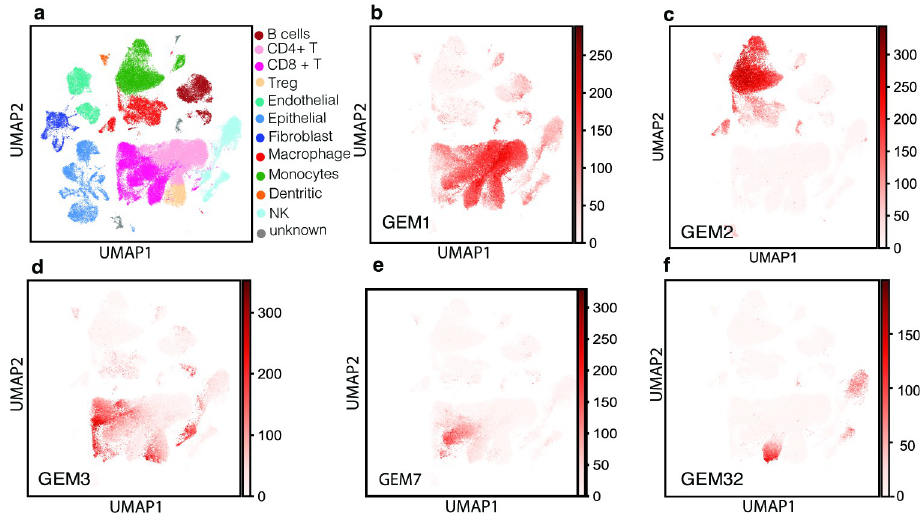
Fig 1. a. UMAP plot of all cells collected from 17 HNSCC tumors. Cells were represented in the original transcriptome and were projected to 2-D space using the UMAP method. Pseudo-colors illustrate the cell types. b–f. Distribution of example immune-cell GEMs among CD45 + cells . The sum of the probabilities of the genes expressed in a cell being a member of an indicated GEM is represented as pseudo-colors.